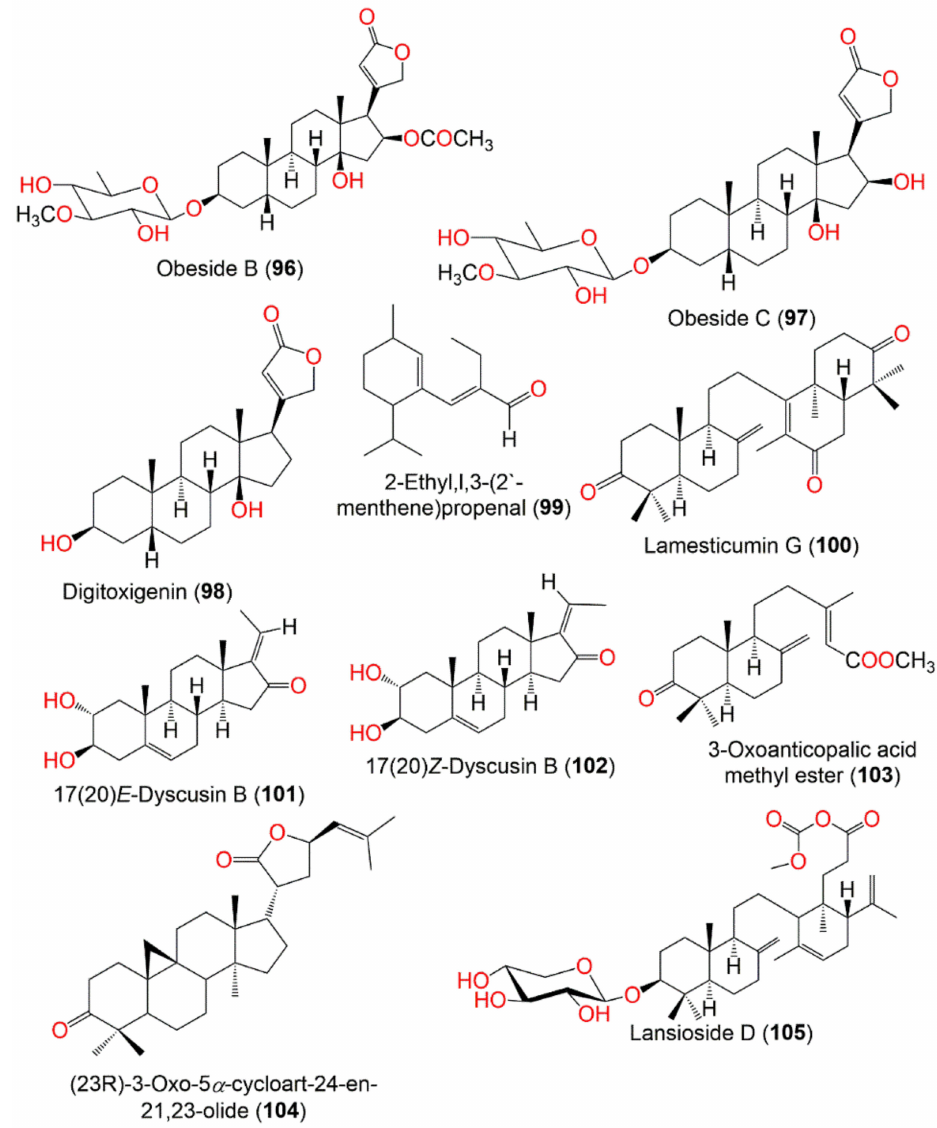
Figure 10. Structures of compounds 96 – 105 from Lansium domesticum